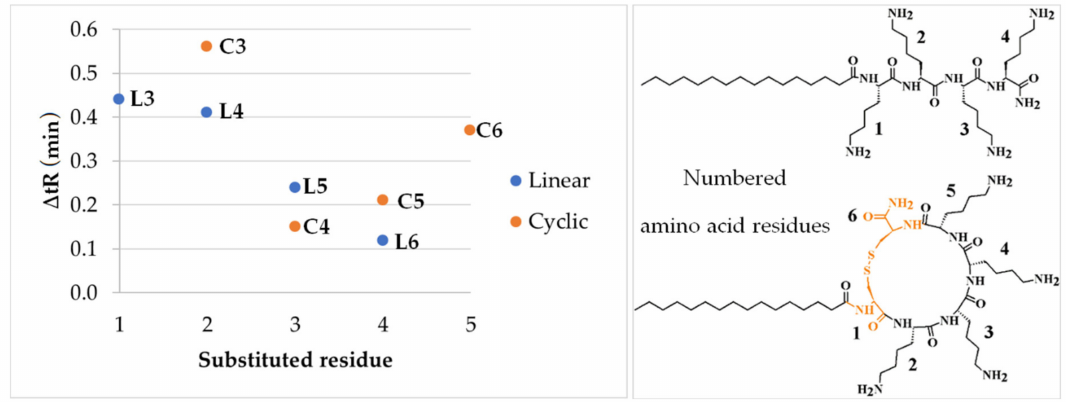
Figure 2. E ff ect of arginine position on retention behavior (left) related to unsubstituted lipopeptides (right). Cysteine / cystine residues are colored